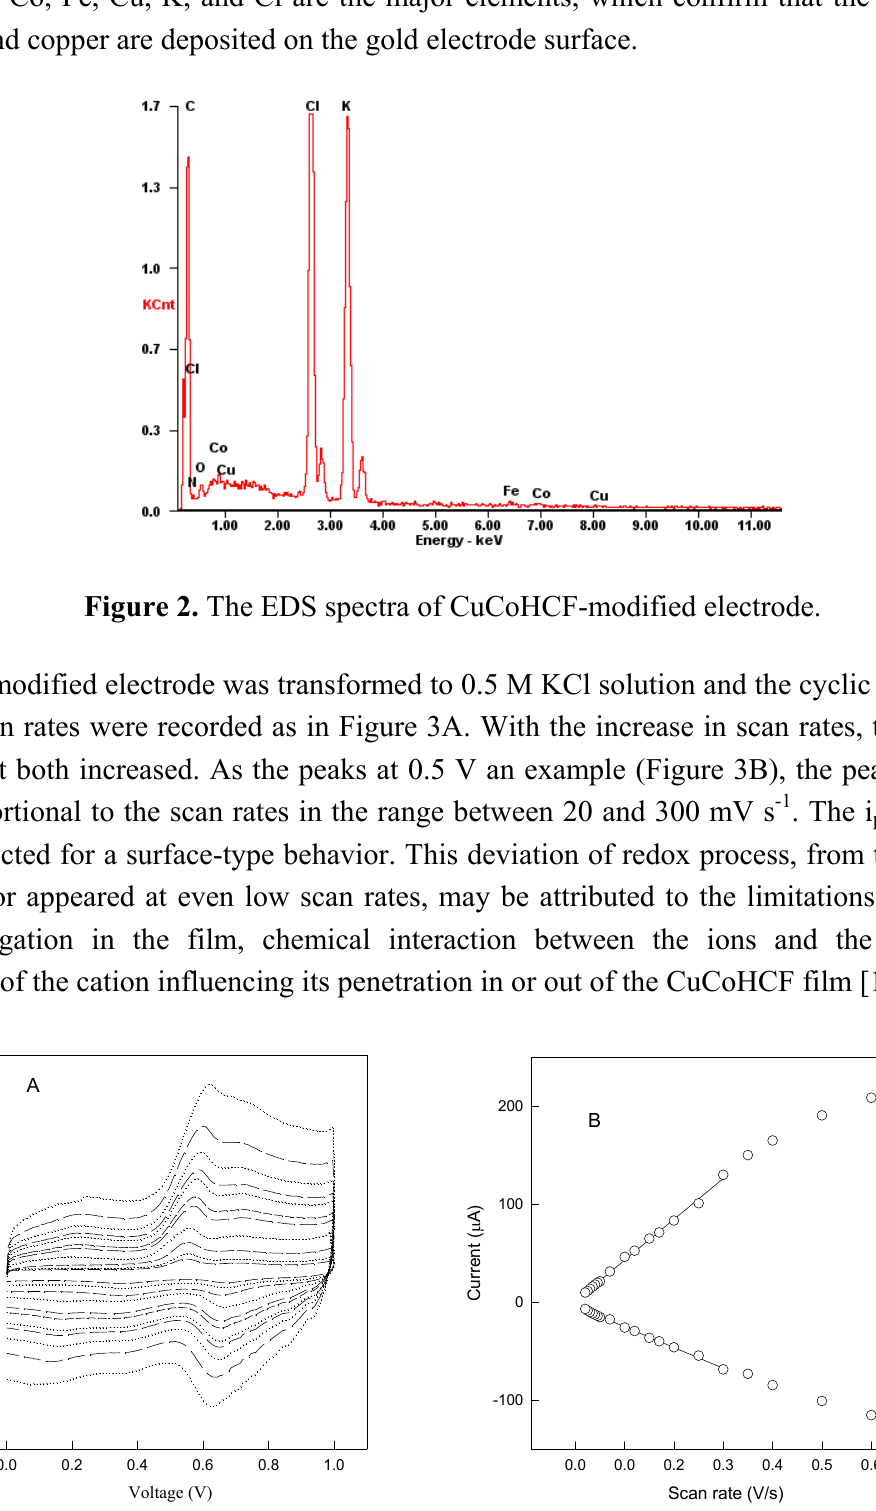
Figure 3. The cyclic voltmmograms of CuCoHCF-modified electrode at various scan rates in 0.5 M KCl solution (A): 20, 30, 50, 70, 100, 120, 150, 170, 200, 250, 300 mV/s. The plot of cathodic and anodic currents at 0.5 V with scan rates